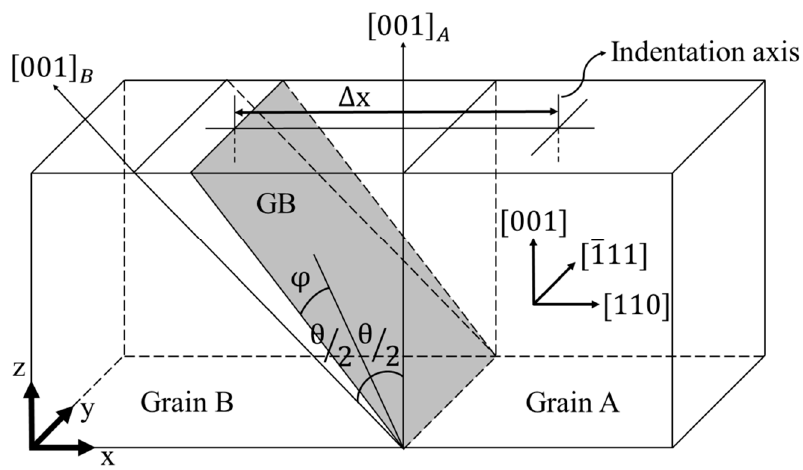
Figure 1. A schematic illustration of the MD simulations of nanoindentation of a fcc bicrystal with a 111 asymmetric tilt boundary. Angle ϕ defines the inclination and equals to the angle between the GB plane and the bisector of the misorientation angle θ . The axis of indentation is located at the center along the y direction and aligned with the normal of the indentation surface. ∆ x specifies the offset along the x axis between the axis of indentation and the GB on the indentation surface. The specimen has dimensions of 80 nm, 80 nm, and 40 nm in the x , y , and z directions, respectively.